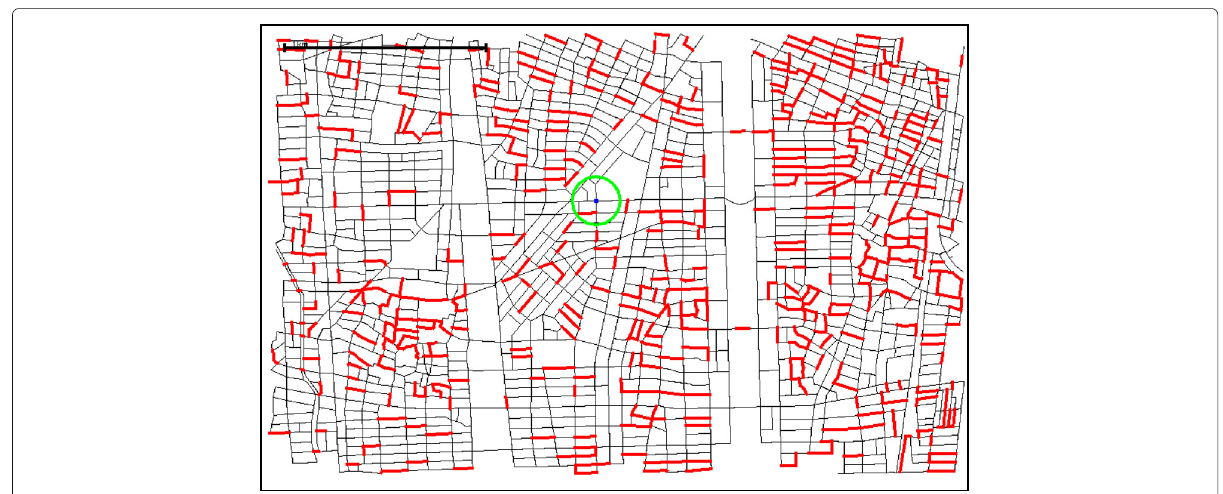
Fig. 4 The map of Nagoya city